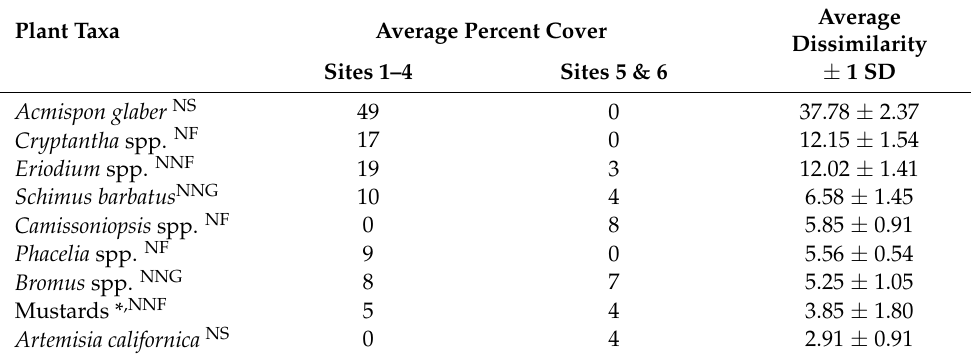
ferences in plant assemblages between experimental (herbivore excluded) and control (herbivore allowed) plots. Each species is followed by a subscript indicating its designation as either a na- tive shrub (NS), native annual forb (NF), native perennial forb (NPF), non-native grass (NNG), or non-native annual forb